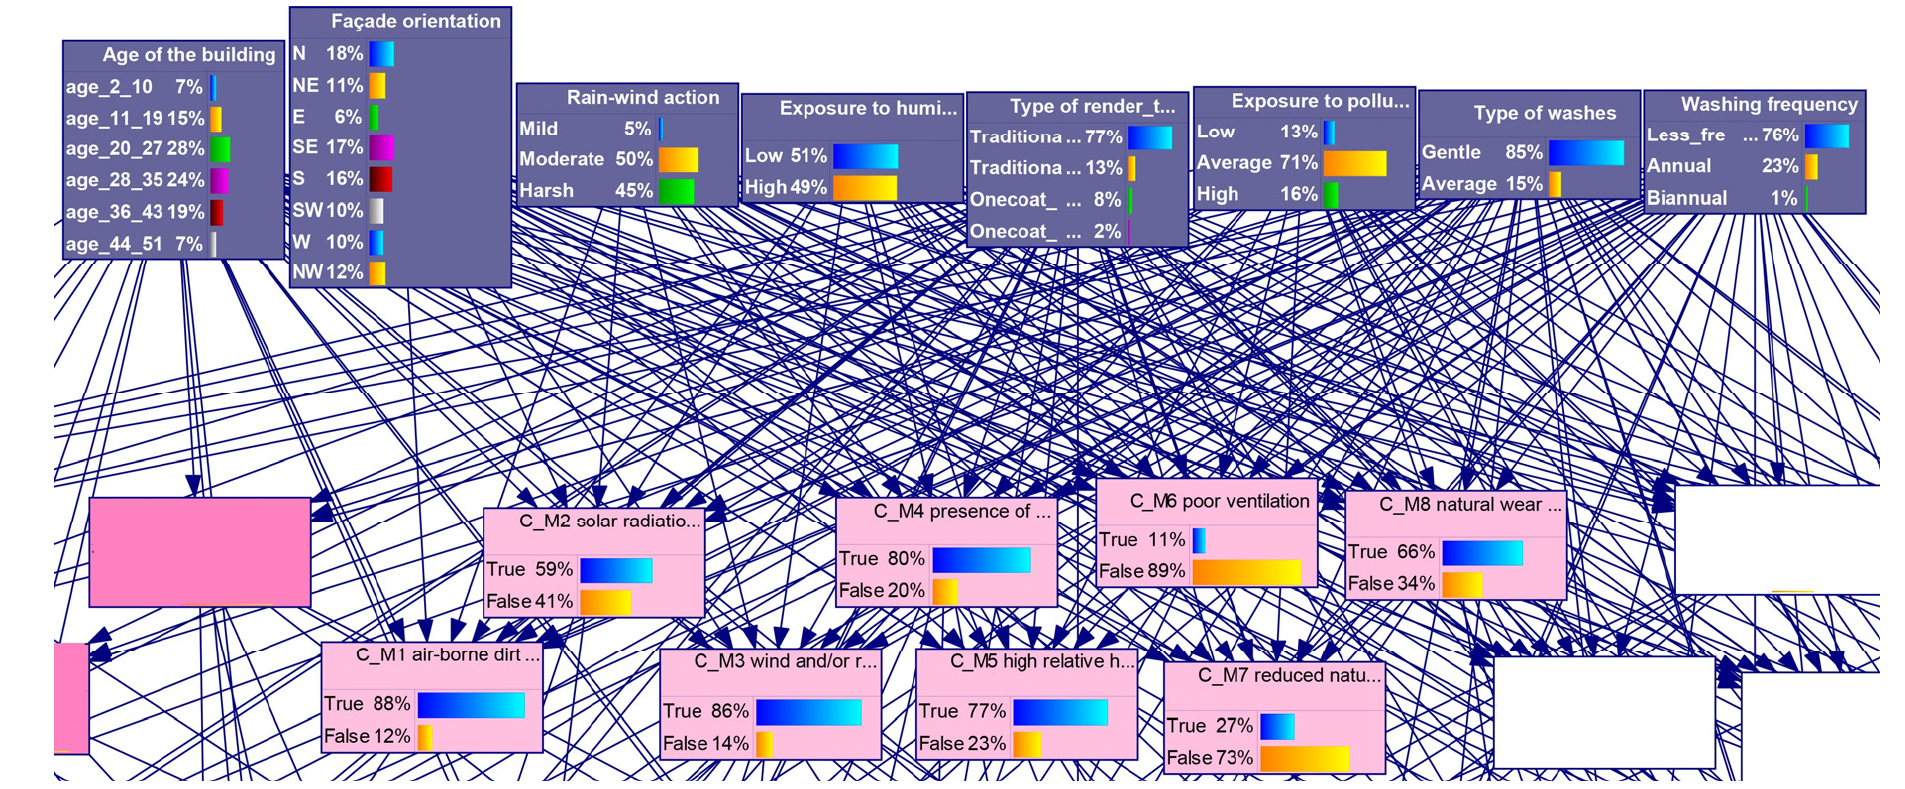
Figure 3. Partial view of the BN model with charts showing the probability of occurrence of environmental and construction characteristics and of environmental action causes of defects